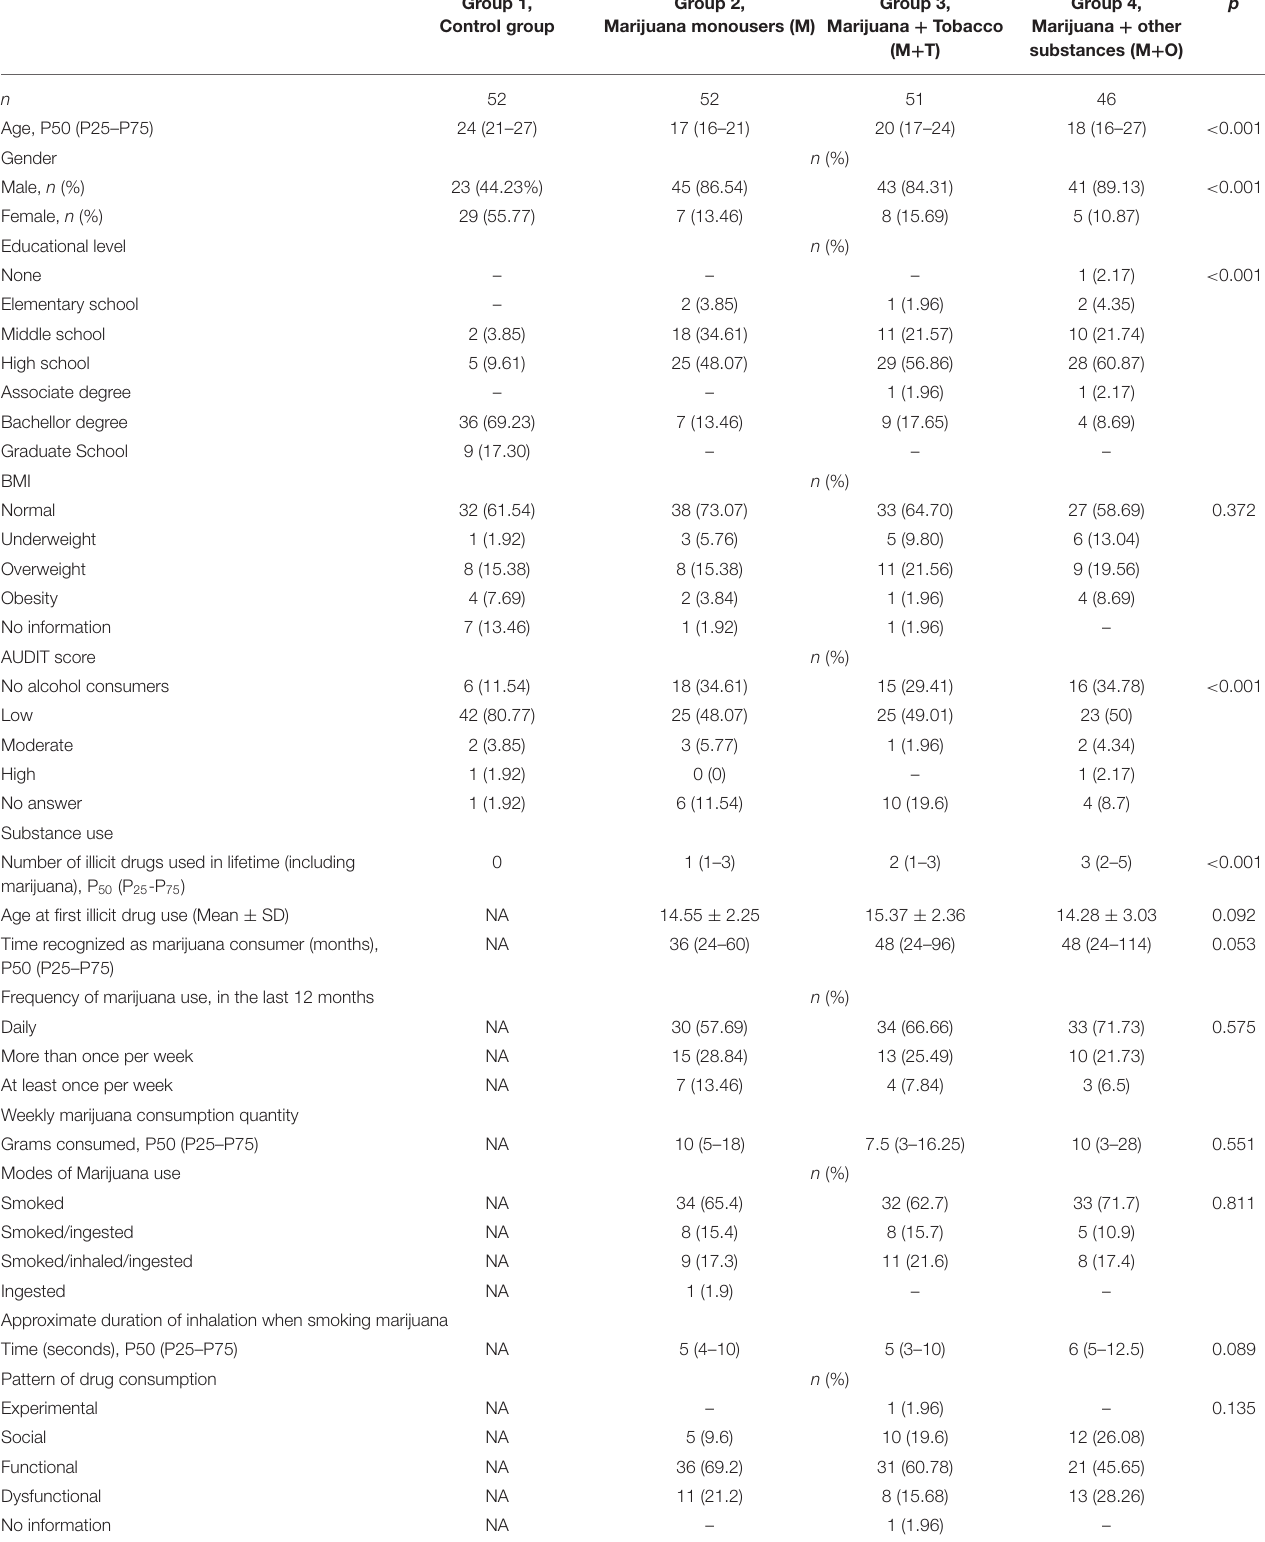
TABLE 1 | Demographics of the participants in this